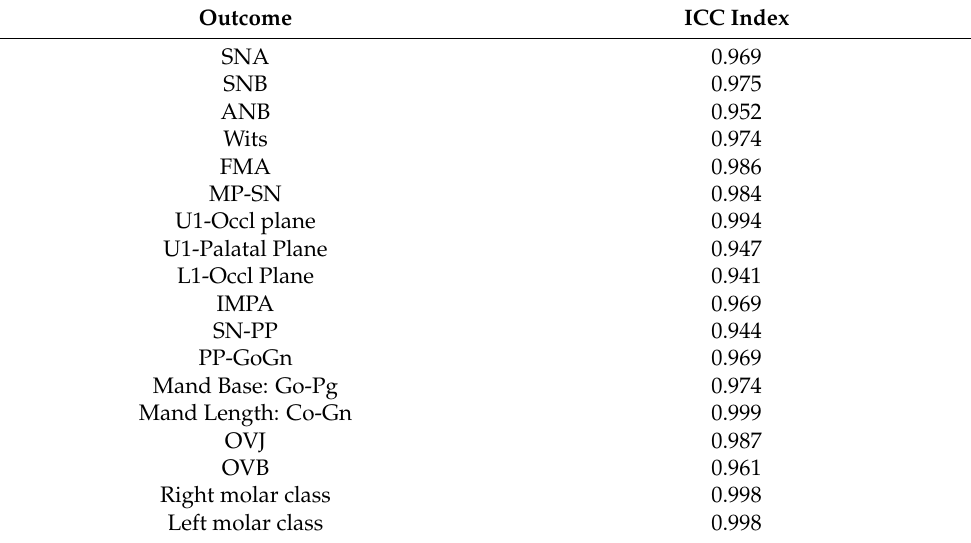
Table 4. Statistical repeatability analysis. ICC index report for each